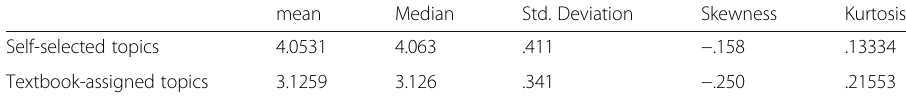
Table 7 The Mean Score for the Participants' Perceptions of Self- Selected Topics and Textbook- Assigned